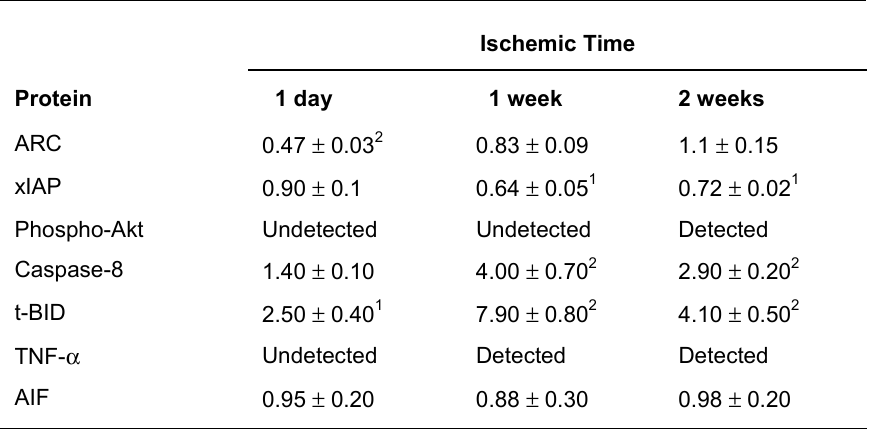
Summary of Protein Expression